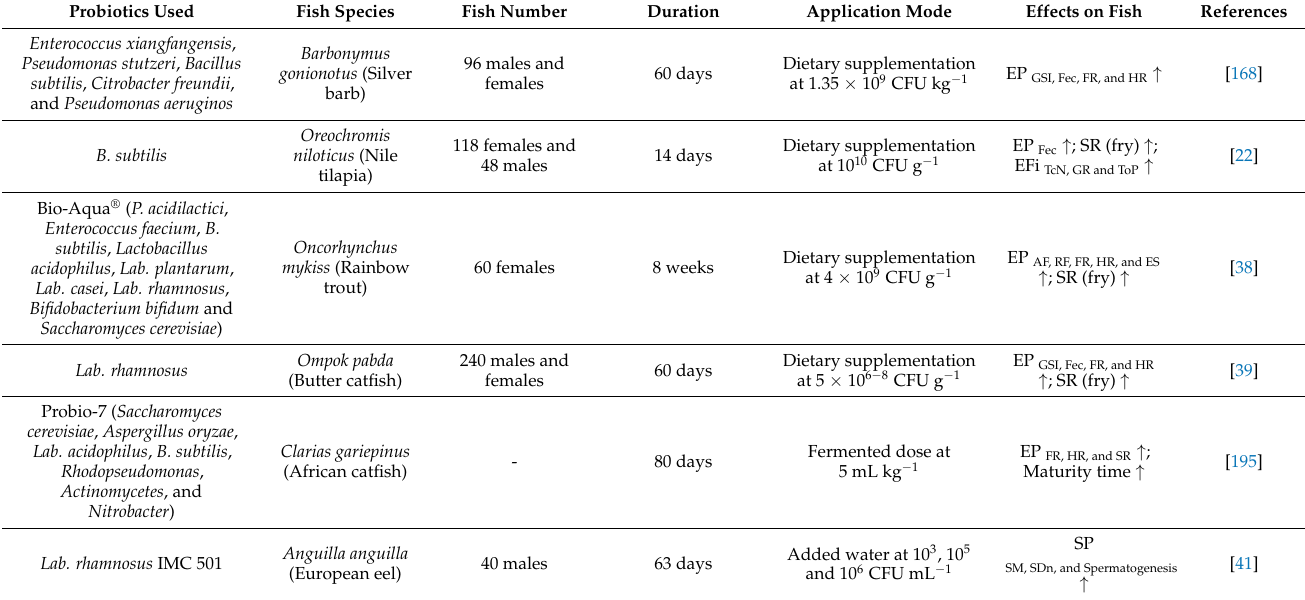
Table 3. Probiotics supplementation effects on commercial fish reproduction. Symbol: increase ( ↑ ) versus